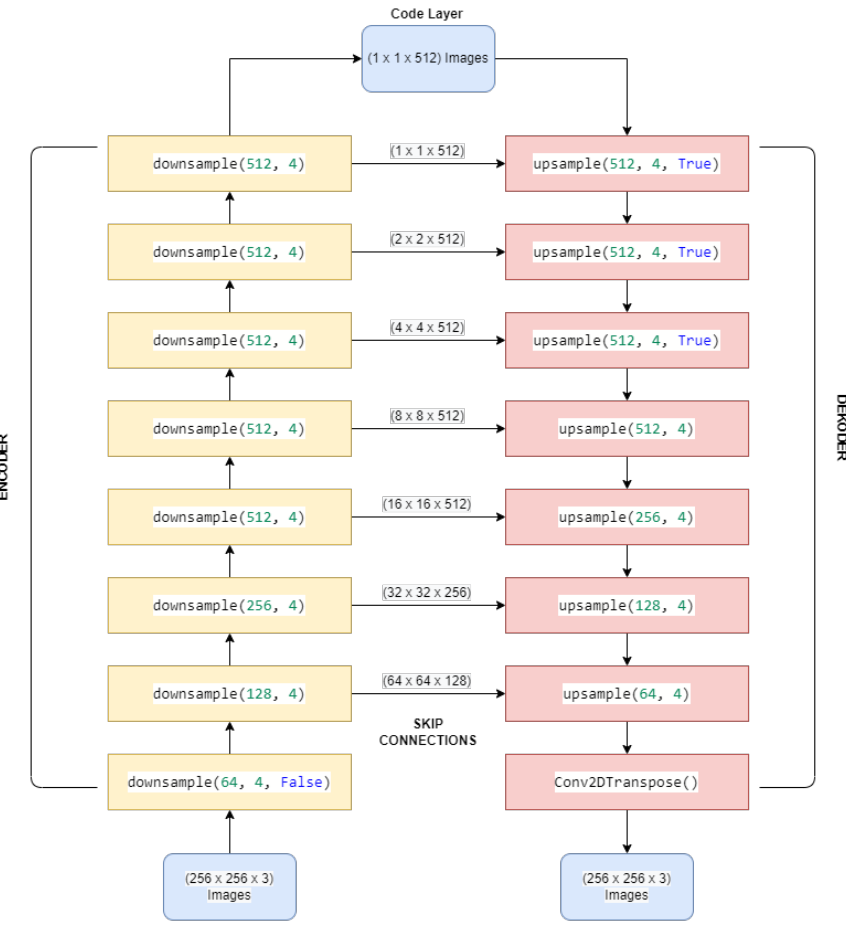
Figure 1. U-NET architecture used as the